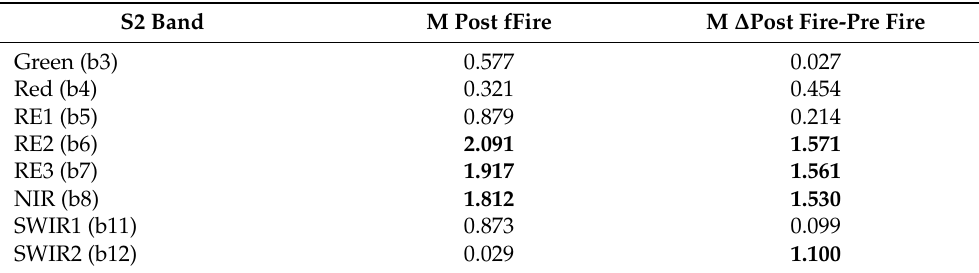
Table 3. Separability metric M measuring the distance between burned and unburned surface spectral signal in the post-fire and post-pre fire reflectance of the S2 bands. Bold numbers highlight values M > 1 of the selected features.